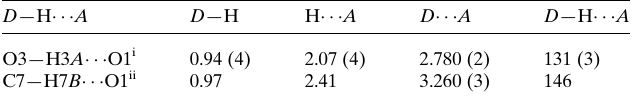
Table 2 Hydrogen-bond geometry (A˚ , (cid:5) ).